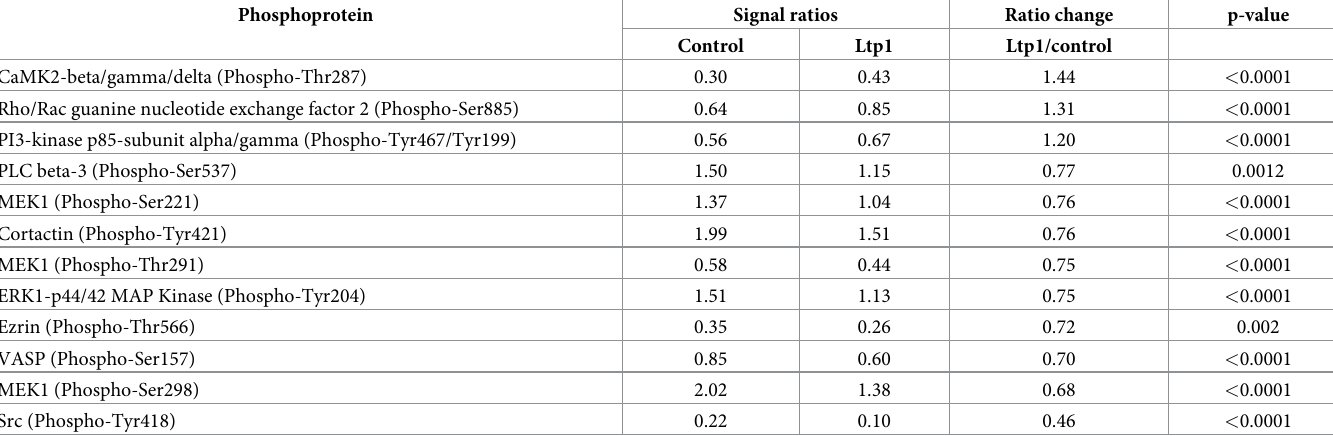
Table 1. Changes in phosphoprotein expression in TIGK cells in response to ectopic expression of Ltp1.